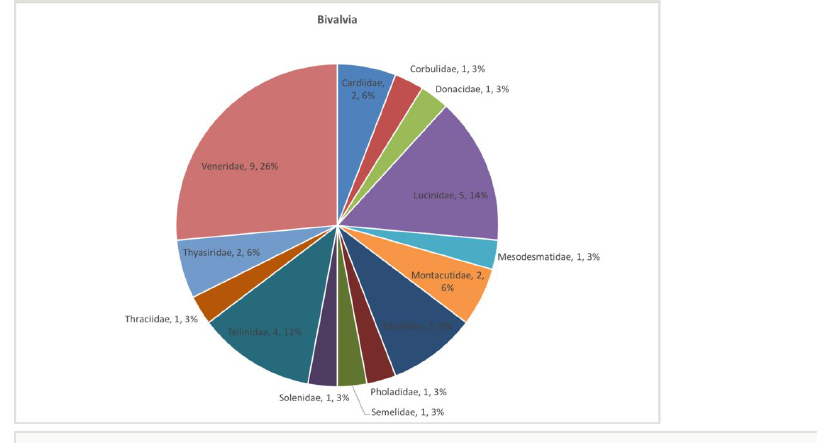
Figure 2. Distribution of species number in the bivalve